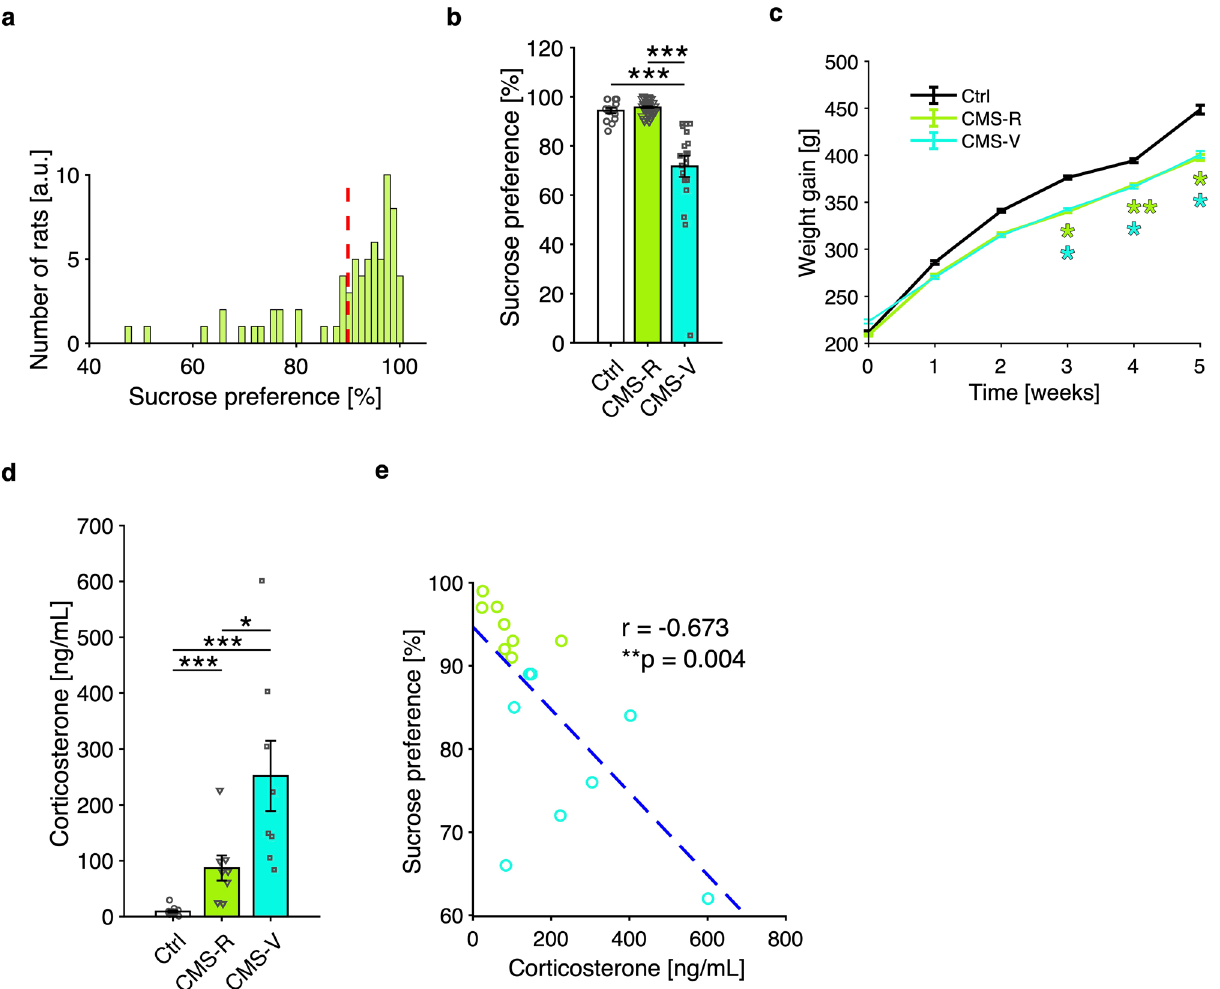
Figure 1. Effects of CMS protocol on sucrose preference, weight gain and serum levels of CORT. ( a ) Distribution of sucrose preference and 90% preference threshold (dashed red line). ( b ) CMS reduces sucrose preference in the SPT in vulnerable (CMS-V) rats if compared to either control (Ctrl) or resilient (CMS-R) rats (n: Ctrl/CMS-R/CMS-V = 14/50/21; K–W test, p < 10 −4 ; permutation tests, B–H correction: CMS-R vs. Ctrl, p = 0.1851; CMS-V vs. Ctrl, p = 0.0003; CMS-V vs. CMS-R, p = 0.0003). ( c ) CMS reduced weight gain in both CMS-R and CMS-V rats from week 3 on (rANOVA: Time F(5,110) = 372.71, p < 10 −4 ; Time x Group F(10,110) = 3.162, p = 0.040; post-hoc analysis with Scheffé’s S procedure: week 3, CMS-R vs. Ctrl, p = 0.011, CMS-V vs. Ctrl, p = 0.023; week 4, CMS-R vs. Ctrl, p = 0.004, CMS-V vs. Ctrl, p = 0.023; week 5, CMS-R vs. Ctrl, p = 0.016; CMS-V vs. Ctrl, p = 0.049; all other comparisons n.s.). ( d , e ) CORT levels are higher for CMS-V rats compared to CMS-R rats, as well as for each of the two groups compared to controls ( d ) (n: Ctrl/CMS-R/ CMS-V = 14/8/8; K–W test, p < 10 −4 ; permutation tests, B–H correction: CMS-R vs. Ctrl, p = 0.0003; CMS-V vs. Ctrl, p = 0.0003; CMS-V vs. CMS-R, p = 0.014), with a significant inverse correlation between sucrose preference in the SPT and CORT ( e ) (Pearson’s correlation: r = − 0.673; p = DA‑LTP, but not DA‑LTD, is occluded in rats vulnerable to CMS. We previously reported that acute mild stress affects a form of LTP that can be induced in mPFC 29 and is strongly dependent on DA action (DA-LTP). Both synaptic potentiation (DA-LTP) and depression (DA-LTD) have been widely characterized 12,37